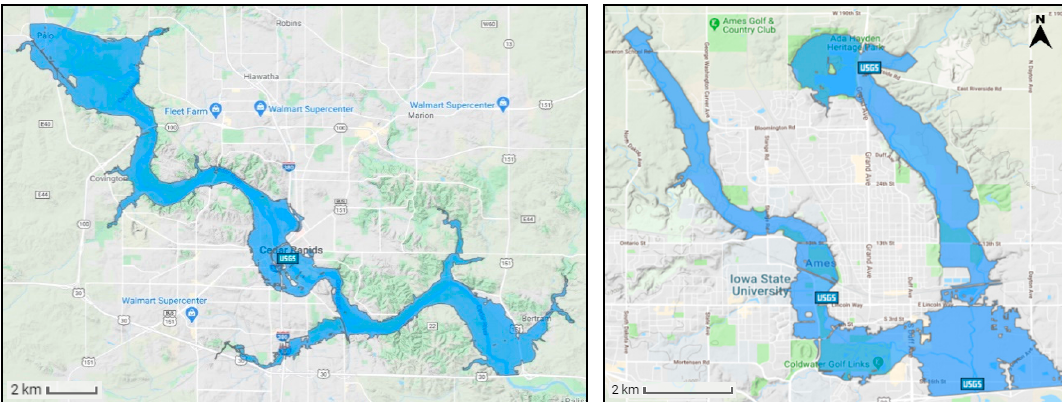
Figure 3. FEMA-approved flood maps for Cedar Rapids ( left ) and Ames ( right ), Iowa by the Iowa Flood Center (IFC). For the Cedar Rapids area, the HAND algorithm ran in roughly 3 s using a mid-range personal laptop and produced an output differing from the reference map predictions by 10%. The flood-fill implementation ran in less than one second and produced an output differing by roughly 15%. For the Ames area, the HAND algorithm (Figure 4) ran in roughly 9 s and produced an output differing from the reference map predictions by 6%.